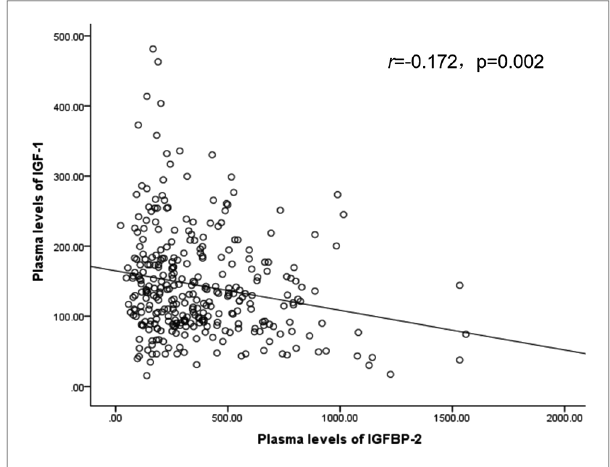
FIGURE 1 Correlation graph of IGF-1 and IGFBP-2. IGF-1: Insulin like growth factor 1; IGFBP-2: Insulin like growth factor binding protein